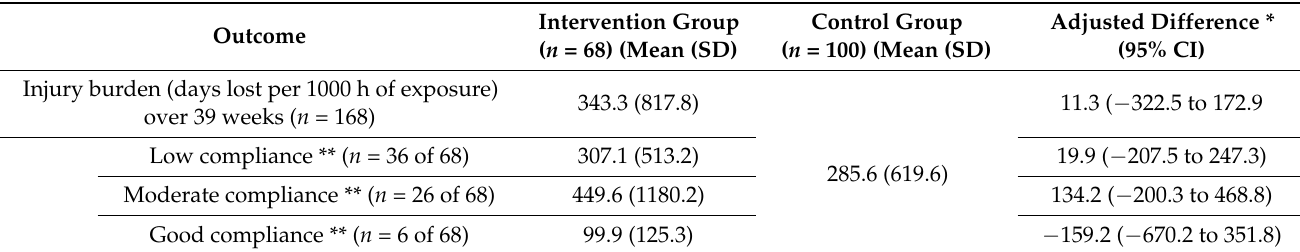
Table 4. Secondary outcome results: comparison of the number of days lost due to injury complaint leading to participation restriction (ICPR) per 1000 h of athletics exposure.